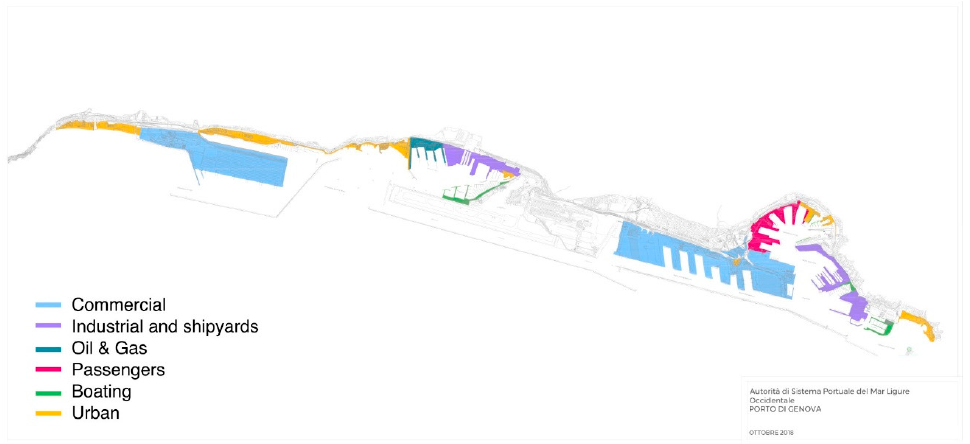
Figure 1. Area of usage of the port of Genoa.